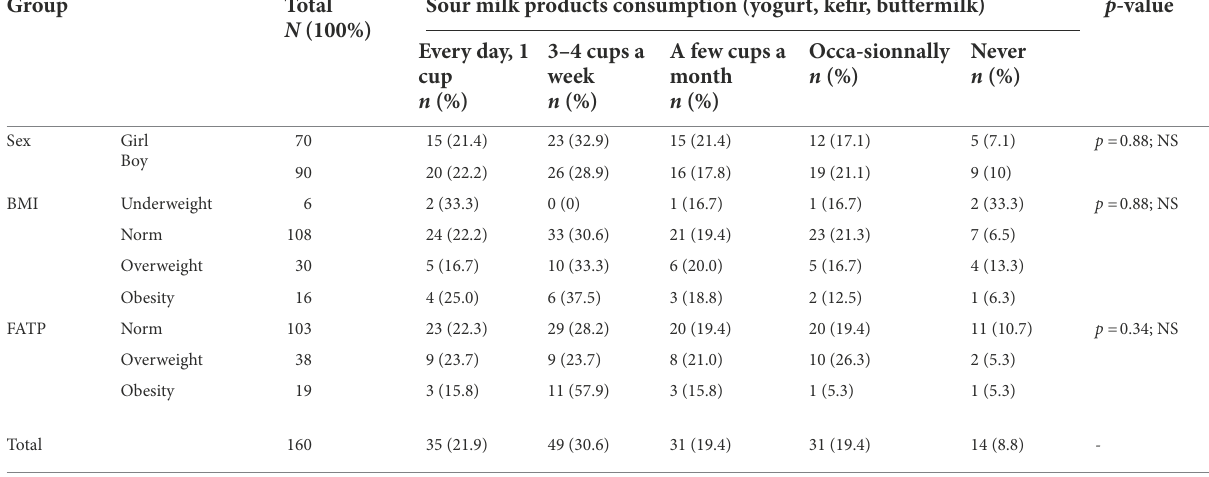
TABLE 3 The frequency of fermented milk product consumption, taking into account sex, the BMI category and the percentage of body fat (FATP). Group